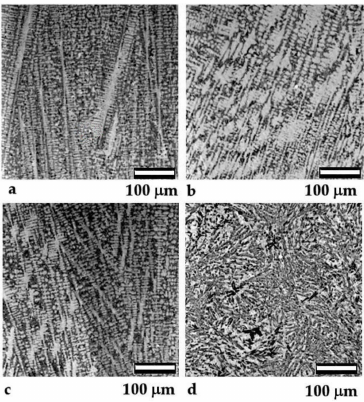
Figure 1. Microstructure of the Ni-based pad weld on the S355 steel: ( a ) non-modified and modified: ( b ) CeO 2 , ( c ) La 2 O 3 , ( d ) Y 2 O 3